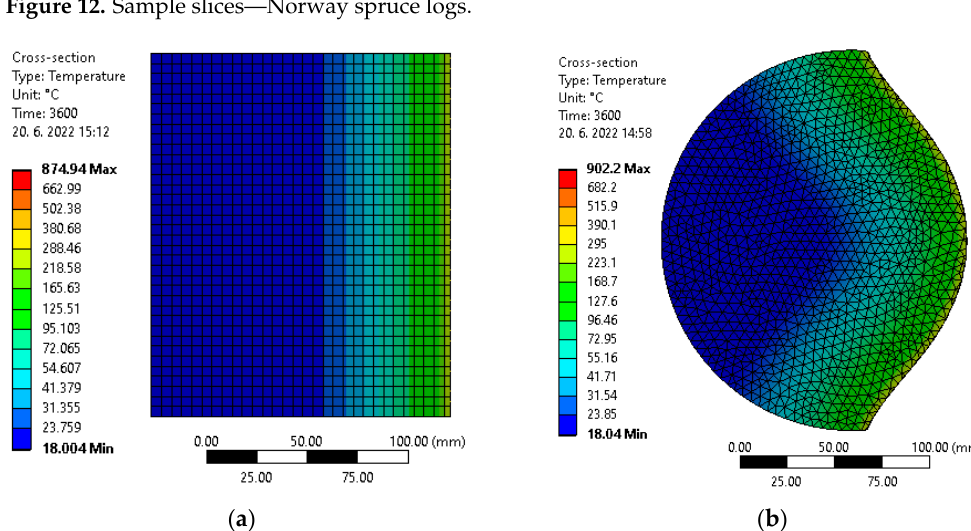
Figure 13. Simulation results: ( a ) Norway spruce prism; ( b ) Norway spruce log.